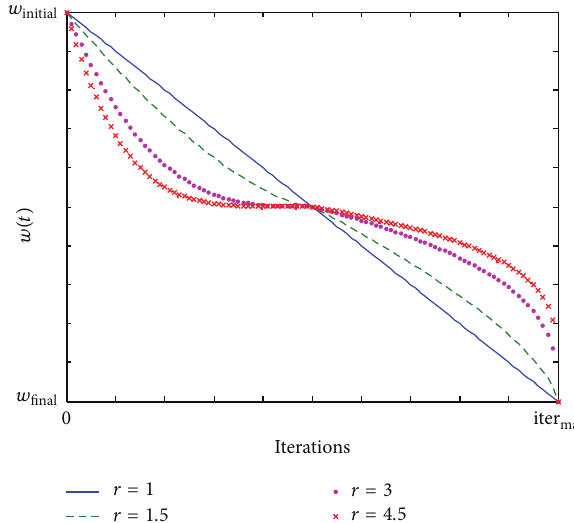
Figure 4: Nonlinear strategy of inertia